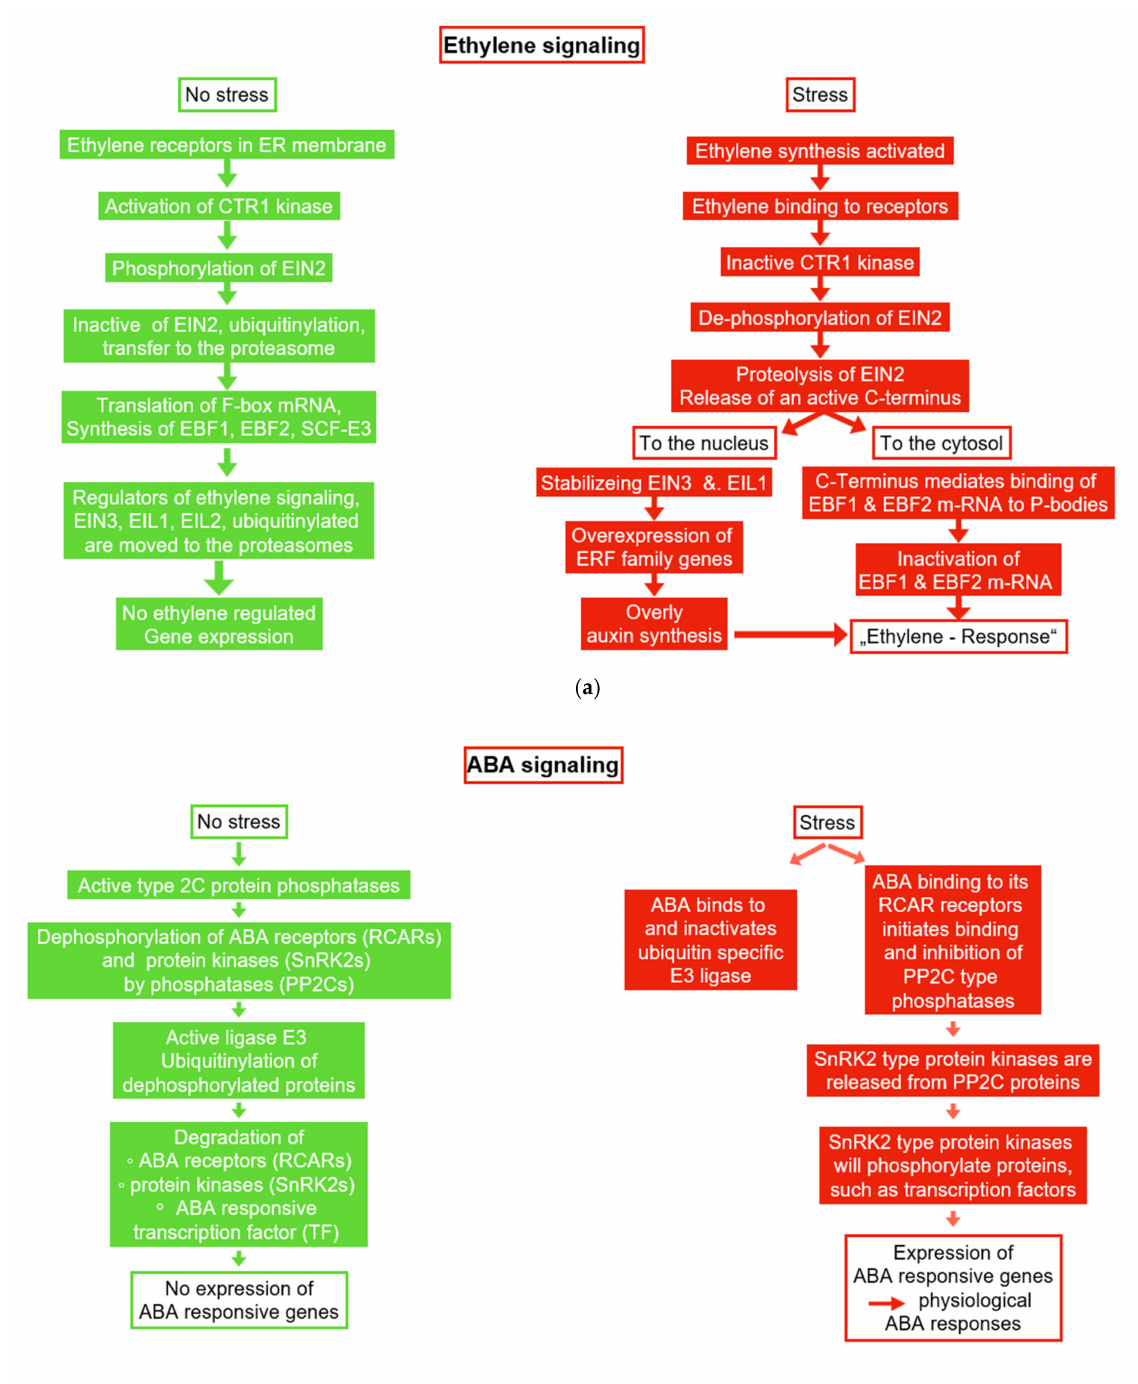
Figure 6. Stress effects on ethylene and ABA signaling. ( a ) Ethylene signaling: The figure indicates how ethylene signaling is modified by stress; ( b ) ABA signaling: The figure indicates how ABA signaling is modified by stress. Abbreviations: EBF1: A transcription factor controlling cell differenti- ation; EIL1: A transcription factor regulating genes that are responsive to sulfur deficit, for instance; EIN2: A factor involved in histone acetylation; ERF: Transcription factor involved in stress responses; PP2C: Protein phosphatase 2C; PYL: Pyrabactin resistance1/PYR1-like regulator component of the ABA receptor; SCF-E3: Serine ubiquitin ligase; SnRK2: A serine/threonine protein